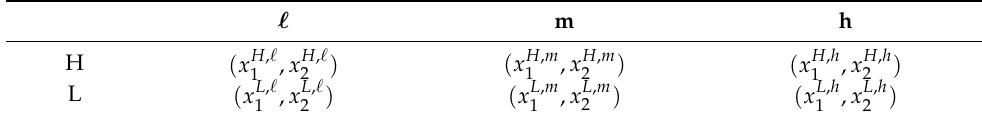
Table 1. A 2 × 3 example. We denote the row player by 1 and the column player by 2. We treat the outcomes as monetary